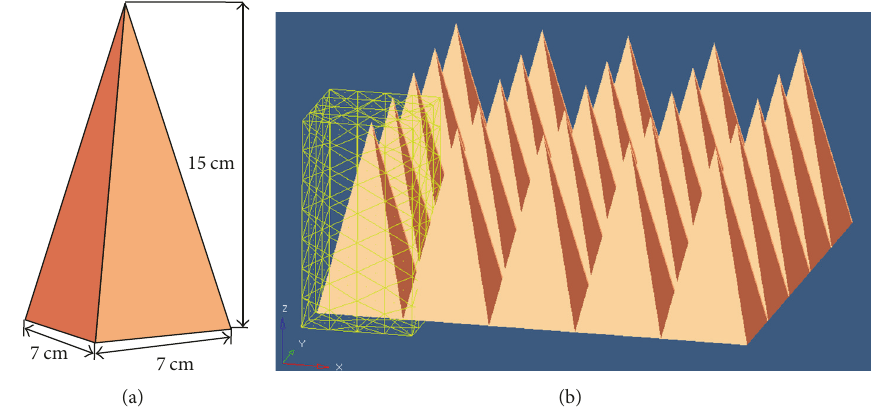
Figure 12: The model of pyramid array: (a) element; (b) 5 × 5 array and equivalence surface.